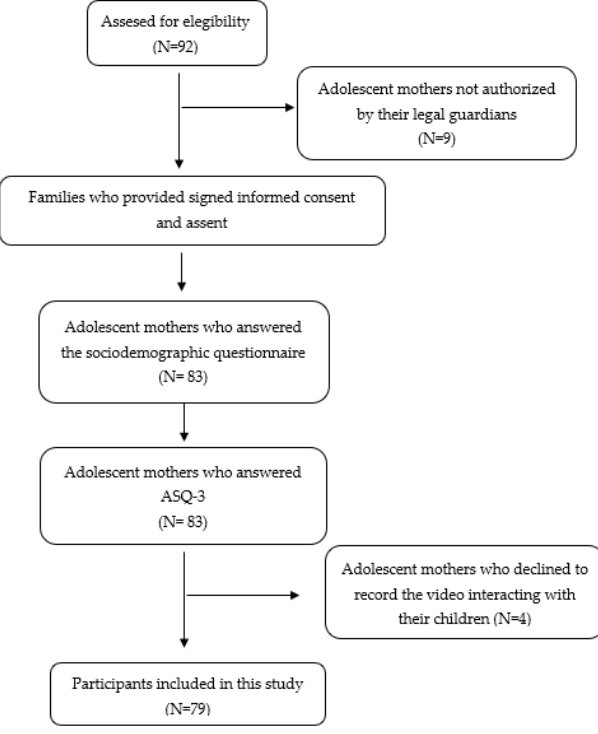
Figure 1. Participant flowchart.